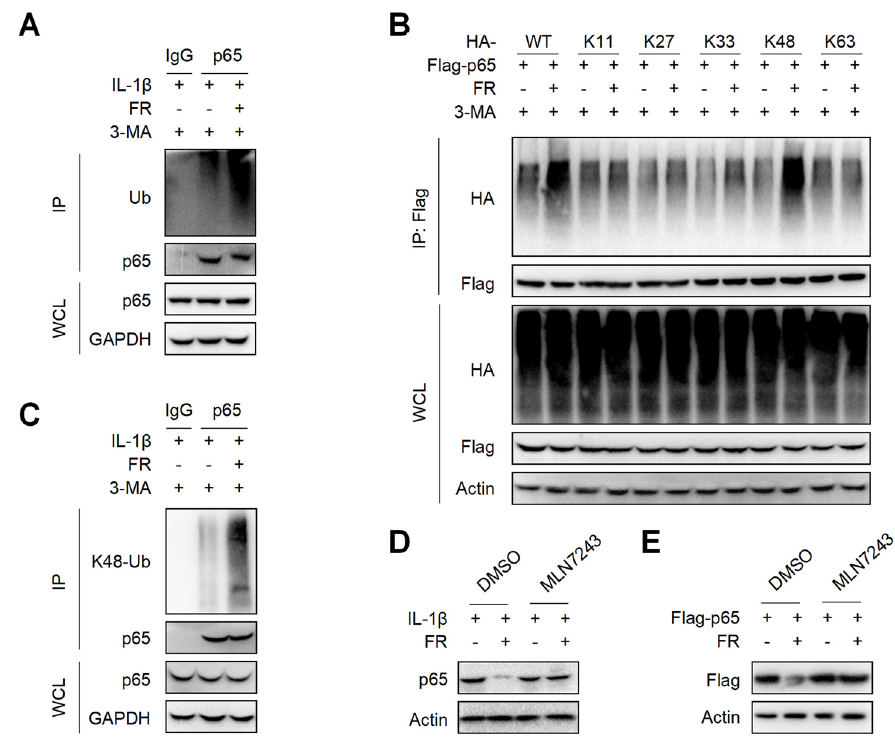
Figure 6. FR promotes the K48-linked ubiquitination of p65 in vitro. ( A ) Tendon cells were pretreated with 3-MA (5 mM) for 6 h, then stimulated with IL-1 β (10 ng/mL) and FR (40 µ M) for 24 h, and cell proteins were collected for IP. WB was used to detect the protein expression of p65 and Ub. ( B ) Flag-p65 and HA-labeled ubiquitinated plasmids (WT, K11, K27, K33, K48, K63) were transfected into HEK293T cells for 24 h, then treated with 3-MA (5 mM) for 6 h, and then treated with FR (40 µ M) for 8 h. Finally, the proteins were collected for IP. WB was used to detect the protein expression with HA tag and Flag tag in IP samples and WCL. ( C ) Tenocytes were pretreated with 3-MA (5 mM) for 6 h, then stimulated with IL-1 β (10 ng/mL) and FR (40 µ M) for 24 h, and cell proteins were collected for IP. WB was used to detect the protein expression of p65 and K48 Ub in IP samples and WCL. ( D ) Tenocytes were pretreated with ubiquitination inhibitor MLN7243 (5 µ M) for 6 h, then treated with IL-1 β (10 ng/mL) and FR (40 µ M) for 24 h, and the expression of p65 protein was detected by WB. ( E ) Flag-p65 plasmid was transfected into HEK293T cells for 24 h, then MLN7243 (5 µ M) was added for 6 h, and FR (40 µ M) was added for 8 h. WB was used to detect the protein expression